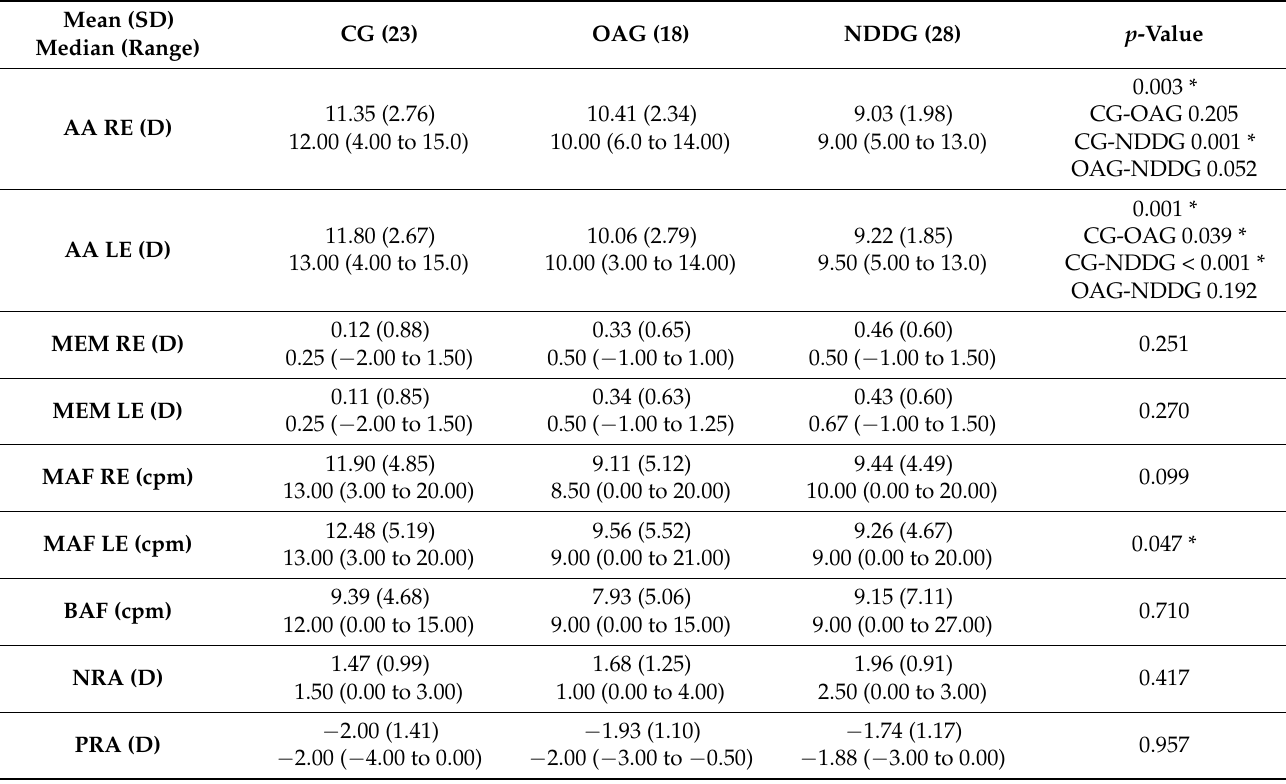
Table 4. Summary of the results of the accommodative examination in the three groups of children evaluated: CG, control group; OAG, group of children with oculomotor abnormalities; NDDG, group of children with neurodevelopmental disorders.